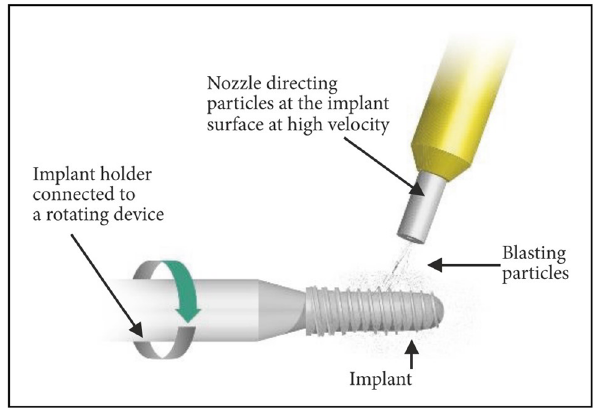
Figure 1: Schematic illustration of the SB process [ 49 ] . Copyright 2014,